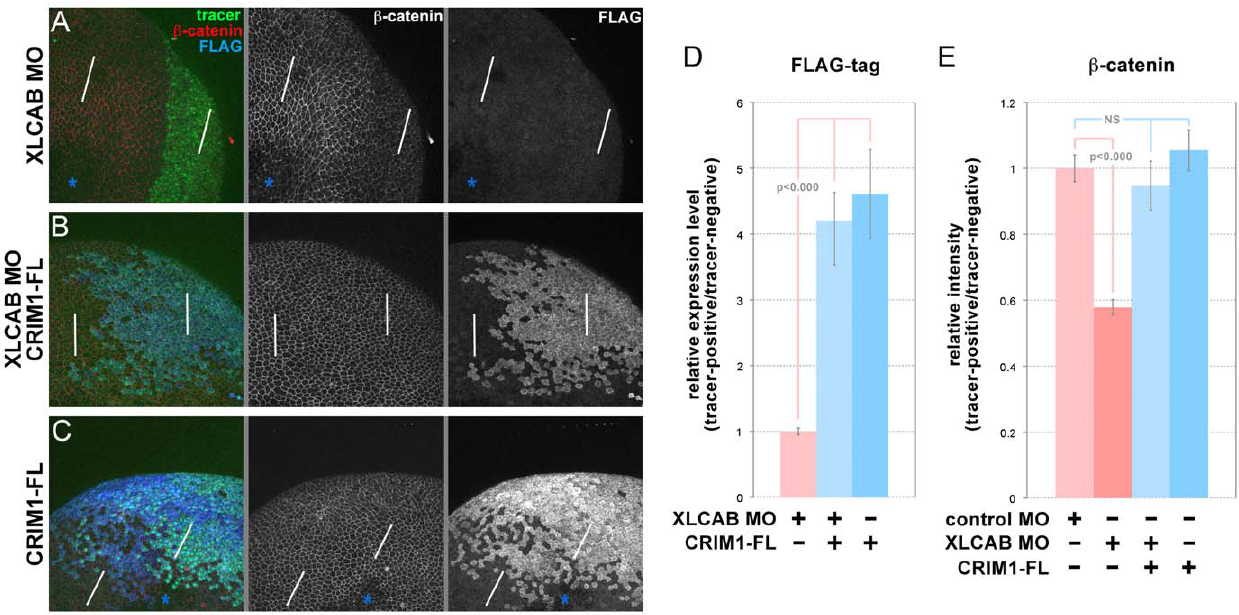
Figure 6. Restoration of CRIM1 expression can rescue ß-catenin level in CRIM1 loss-of-function embryos. ( A–C ) Whole-mount immunofluorescence labeling of stage 13 Xenopus embryos in which XLCAB MOs, MO-resistant mRNA of FLAG-tagged full-length CRIM1 (CRIM1-FL) or a combination of the two were injected at the 4-cell stage, together with dextran tracer. In (A and C) the asterisks indicate regions where labeling in the apical junctional complex were not imaged due to the optical sectioning plane. ( D ) Quantification of relative expression level of FLAG-tagged CRIM1 protein by calculating the ratio of average pixel intensity of FLAG labeling over 150 pixel line intervals placed in tracer-positive or tracer- negative regions (white bars in A–C). ( E ) Quantification of relative expression level of ß-catenin by calculating the ratio of average pixel intensity of ß- catenin labeling over 150 pixel line intervals placed in tracer-positive or tracer-negative regions (white bars in A–C).